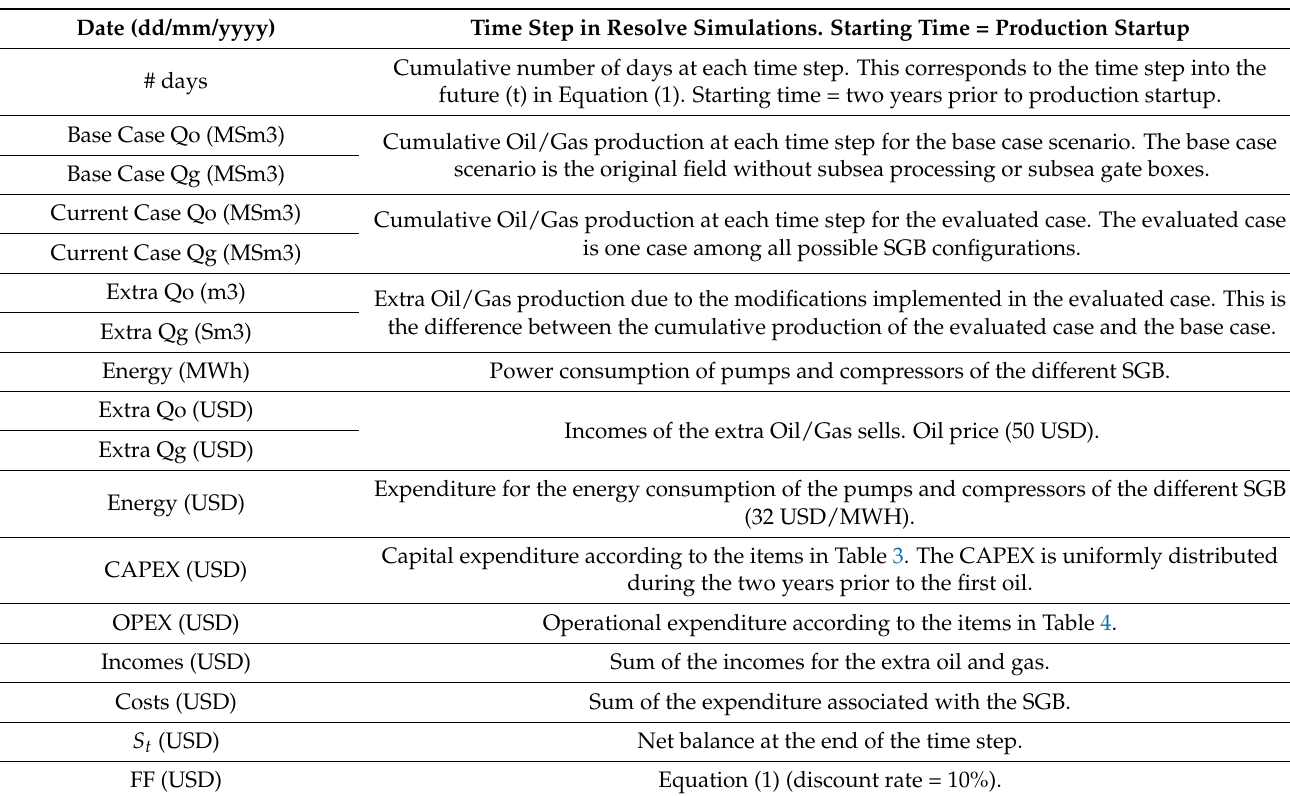
Table 2. Fitness function spreadsheet to calculate Equation (1). SGB: subsea gate